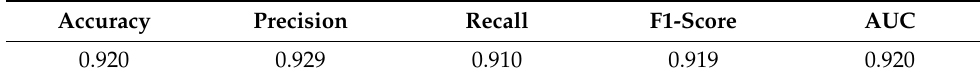
Figure 11. Confusion matrix and ROC curve of similarity model. Table 4. Performance of similarity